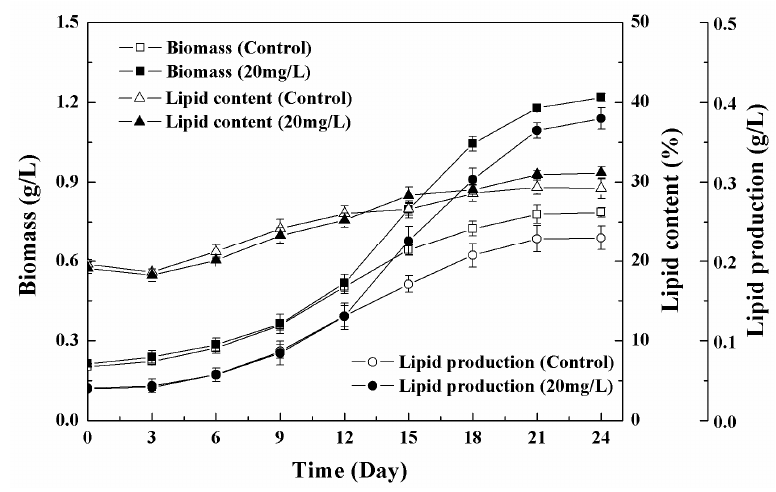
Figure 5. Change in biomass, total lipid contents, and lipid production of Chlorella sp . UJ-3 exposed to 20 mg/L Fe 3 O 4 NPs.